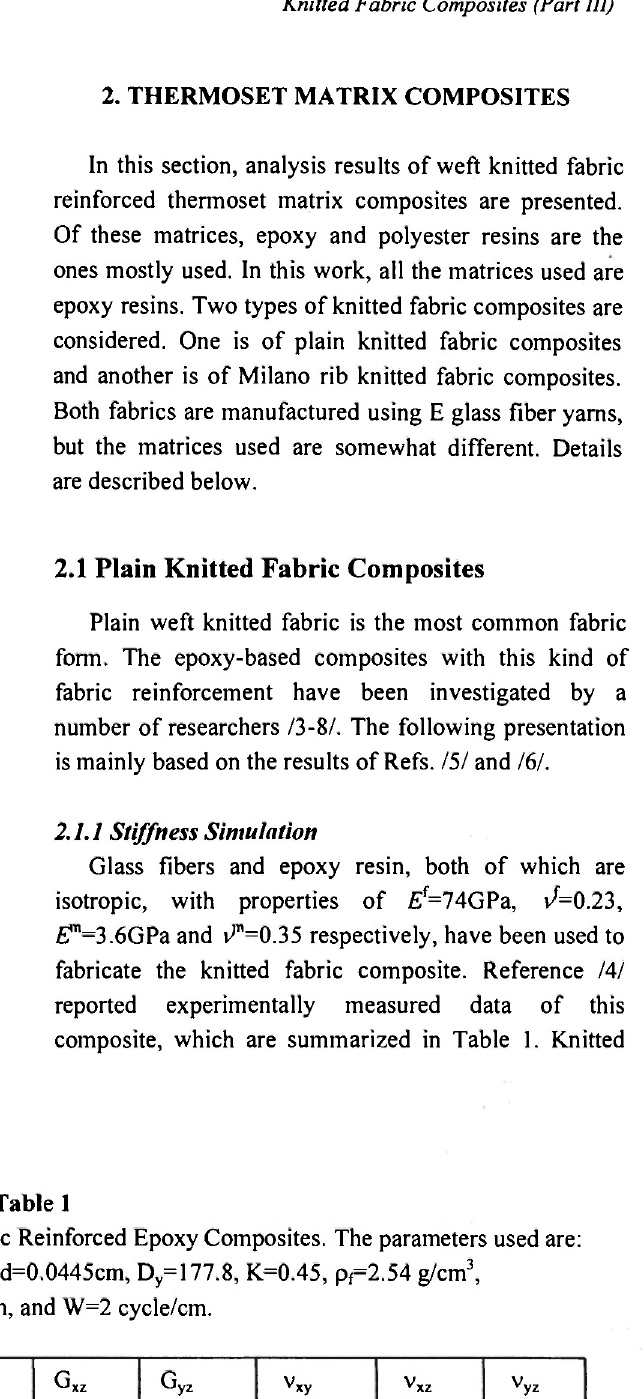
Elastic Properties of Plain Knitted Glass Fiber Fabric Reinforced Epoxy Composites. The parameters used are: E f =74GPa, v f =0.23, E m =3.6GPa,v m =0.35,d=0.0445crn, D y =177.8, K=0.45, p,=2.54 g/cm 3 , C=2.5 cycle/cm, and W=2